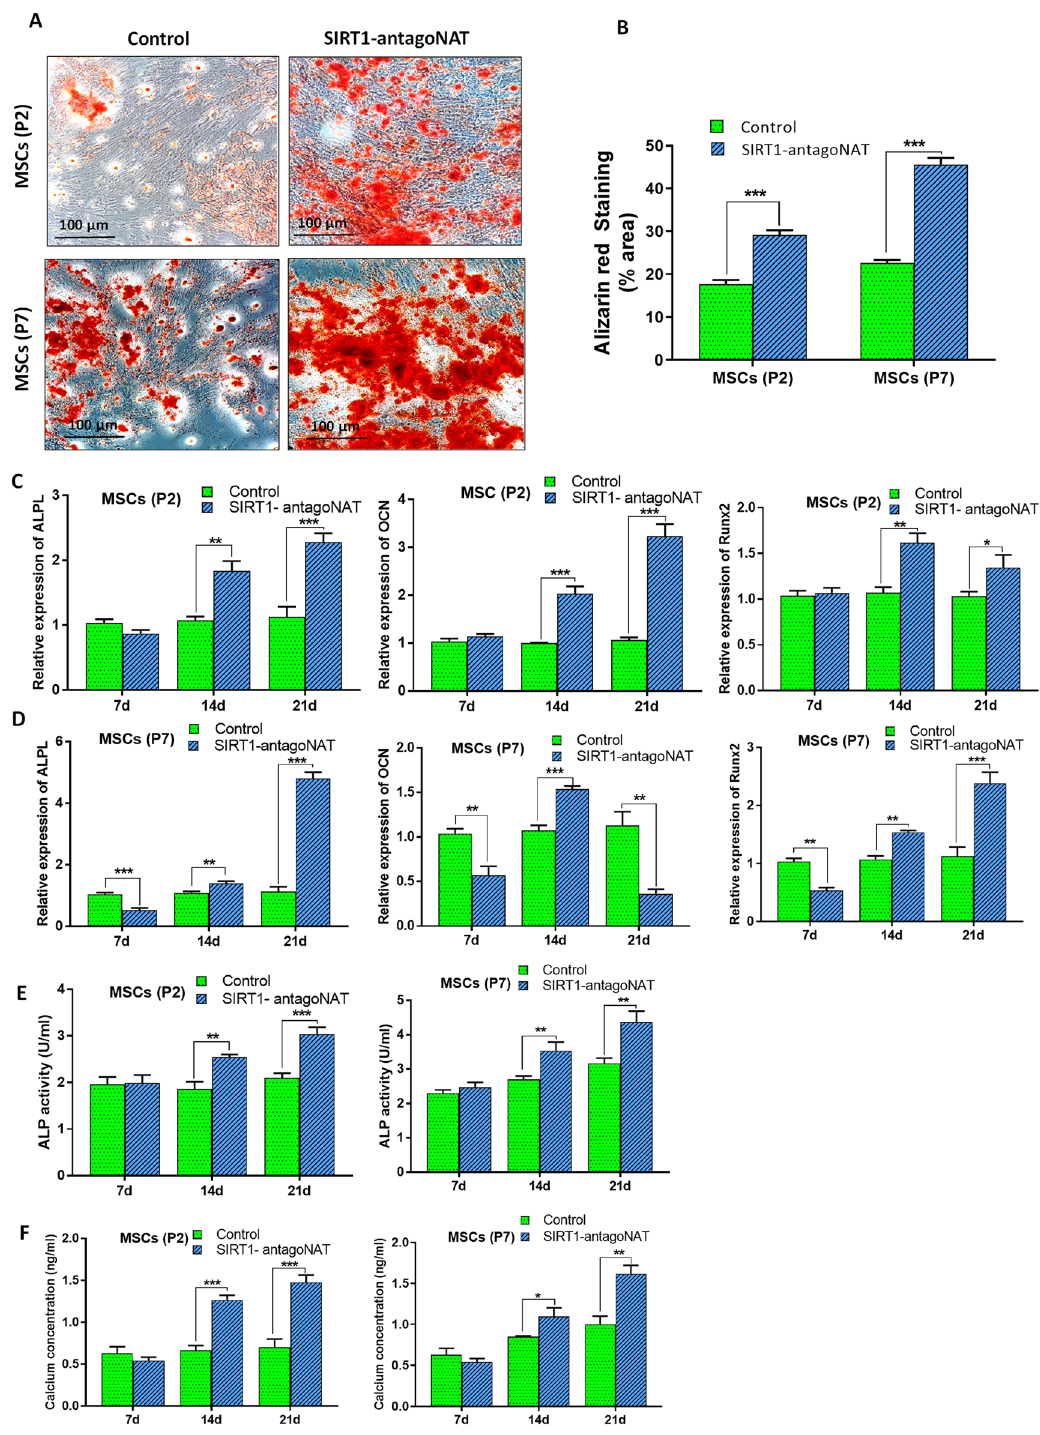
Figure 6. Osteogenic differentiation potentials of MSCs is enhanced following Knockdown of SIRT1-NAT. ( A ) Representative photomicrographs which show the Alizarin red staining following the osteogenic induction of P2 and P7 MSCs transfected with SIRT1-antagoNAT and their controls. ( B ) Bar graphs quantifying the results of Alizarin red staining represented in ( A ). Compared with controls, the percentage of area stained by Alizarin red was higher in SIRT1-antagoNAT treated MSCs directed toward osteogenic fate. ( C , D ) Bar graphs showing the relative expressions of ALPL, OCN, and Runx2 (osteoblast marker genes) in P2 ( C ) and P7 ( D ) MSCs treated with SIRT1-antagoNAT and their controls during the 3 weeks period of osteogenic induction, as determined by RT-qPCR. Each time point was used as its own reference. ( E ) Bar graphs showing the higher ALP activity in SIRT1-antagoNAT treated P2 and P7 MSCs during osteogenic induction compared with controls. ( F ) Bar graphs showing the higher calcium content in P2 and P7 MSCs transfected with SIRT1-antagoNAT during the osteogenic induction, compared with controls. Data are expressed as mean ± SD (n = 3). Data in B are obtained from 6 microscopic fields (2 independent experiments). * p < 0.05, ** p < 0.01, *** p <